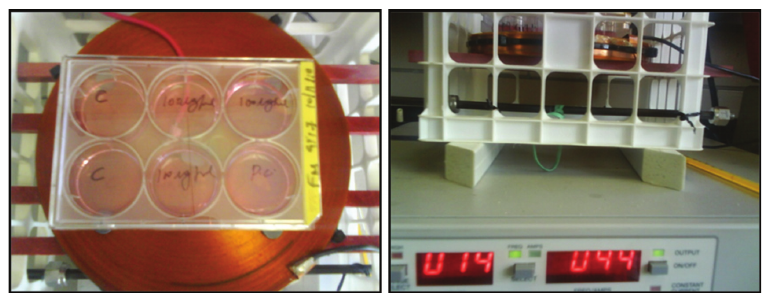
Figure 1 A custom-made Behlman AC magnetic field setup used for treating GT1-7 neurons and LNCaP cells in vitro . The instrument was sterilized each time it was used. The culture plates, placed onto the top of copper coil, were exposed to a magnetic field strength of 465 Oe applied at a frequency of 44 Hz for 15